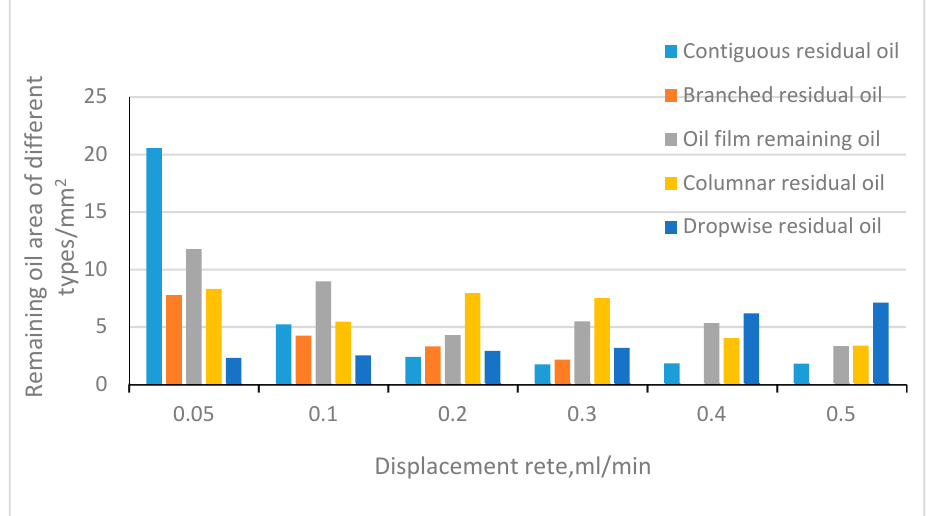
Figure 9. Comparison histogram of different types of remaining oil area with different displacement rates.